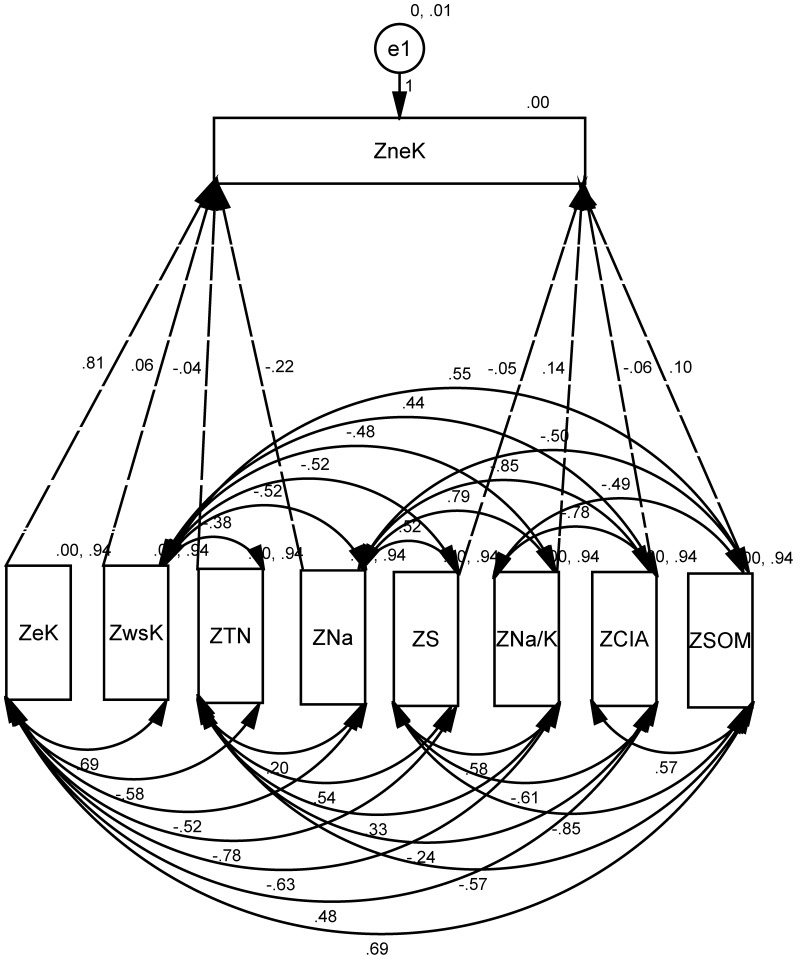
Path model of non-exchangeable potassium (neK, solid line for double arrow, dashed-line for single arrow, and single arrow flows into ZwsK).